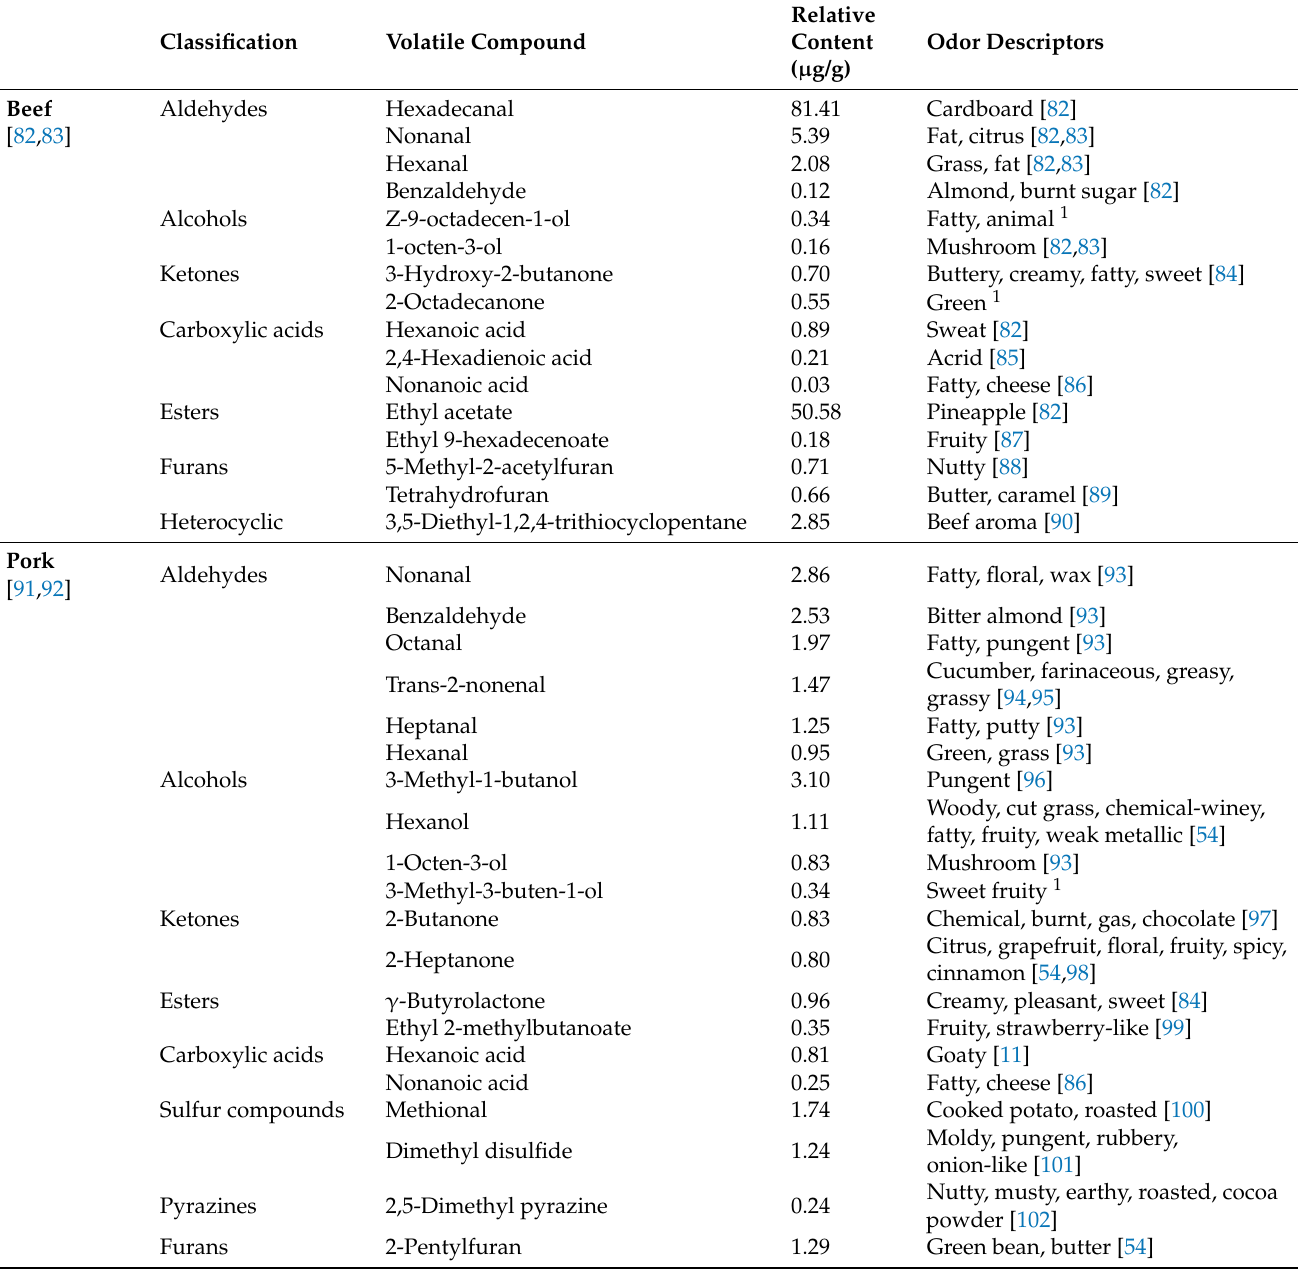
Table 2. Types and relative contents of characteristic odor compounds in different thermally processed meats detected by gas chromatography-olfactometry [12]